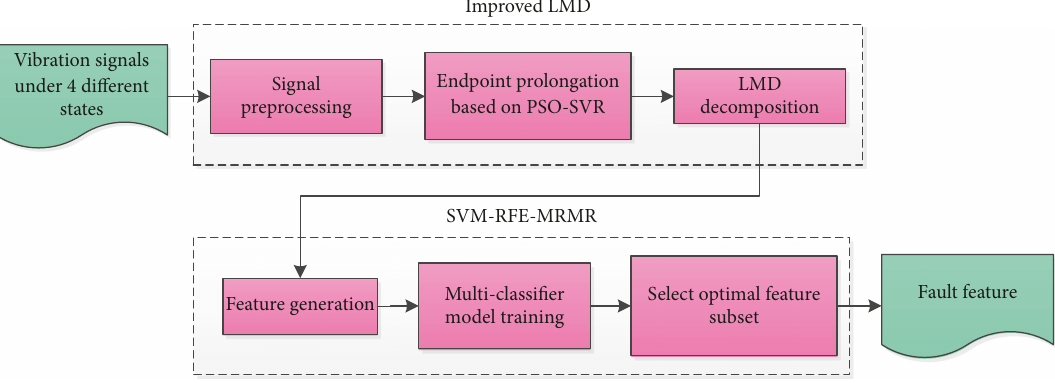
Figure 9: Flowchart of fault diagnosis for reducer.